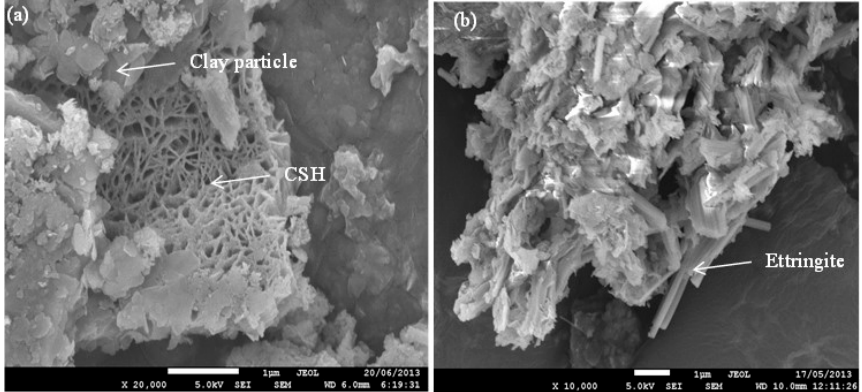
Figure 5. Secondary electron imaging (SEI) of ( a ) ASS treated with 15 wt % lime and 15 wt % slag at 365 days curing and ( b ) ASS containing 4 wt % additional pyrite and treated with 15 wt % lime and 20 wt % slag at 365 days curing.